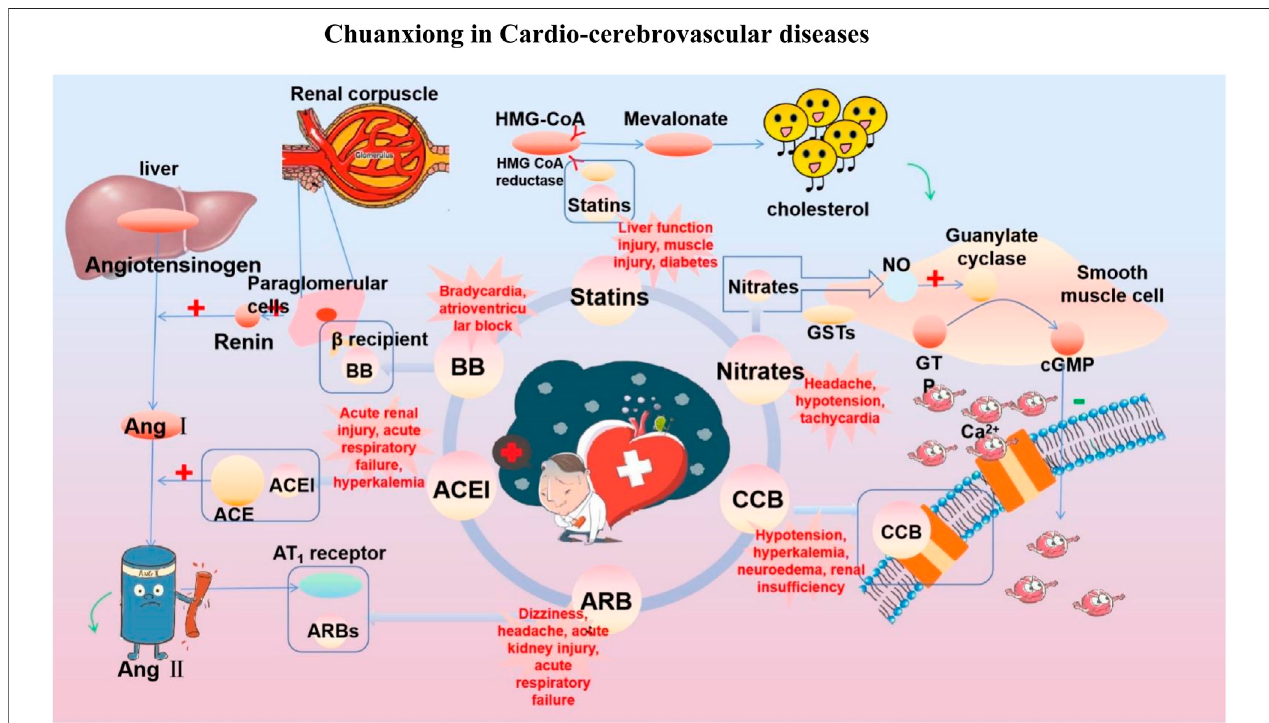
FIGURE 3 | Commonly used drugs for CVD and their mechanisms (the green symbol indicates the effect after administration, and the red symbol indicates the pathological condition. Commonly used drugs for CVDs include statins, BB, ACEI, ARBs, CCB, and nitrates. Angiotensin produced by the liver is converted to Ang I undertheactionofrenin secretedbyjuxtaglomerularcells,andthentoAngIIundertheactionofACE.AngIIcanbindtoAT1receptorandproducevasoconstriction.BB can bind to β receptor of adjacent glomerular cells and reduce the secretion of renin. ACEI can inhibit ACE and reduce Ang II. ARBs can bind to AT1 receptor and competitively inhibit the binding of Ang II to AT1 receptor. BB, ACEI, and ARBs play a role in the renin – angiotensin system, thereby inhibiting vasoconstriction, reducing blood volume, and lowering blood pressure. CCB can directly block the Ca 2+ channel on the endothelial cell membrane and reduce Ca 2+ in fl ux, thereby reducing blood pressure and myocardial contractility. HMG-CoA is transformed into mevalonate by HMG-CoA reductase, and then into cholesterol. Statins can signi fi cantly reduce blood cholesteroland LDLbyinhibiting HMG-CoA reductase, thus achievingtheeffect ofloweringblood lipid. NitratescatalyzedthereleaseofNOinthesmoothmuscle cells by GSTs, and NO activates guanylate cyclase, increasing the content of intracellular second messenger cGMP, and then activating cGMP-dependent protein kinase, which reduces intracellular Ca 2+ release and extracellular Ca 2+ in fl ux and relaxes smooth muscle